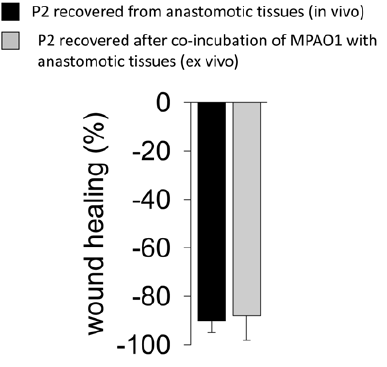
Figure 5. Wound healing assay. The P2 strain recovered from anastomotic tissues ( in vivo ) and the P2 strain recovered after co- incubation of MPAO1 with anastomotic tissues ( ex vivo ) similarly destroy wounded epithelial IEC-18